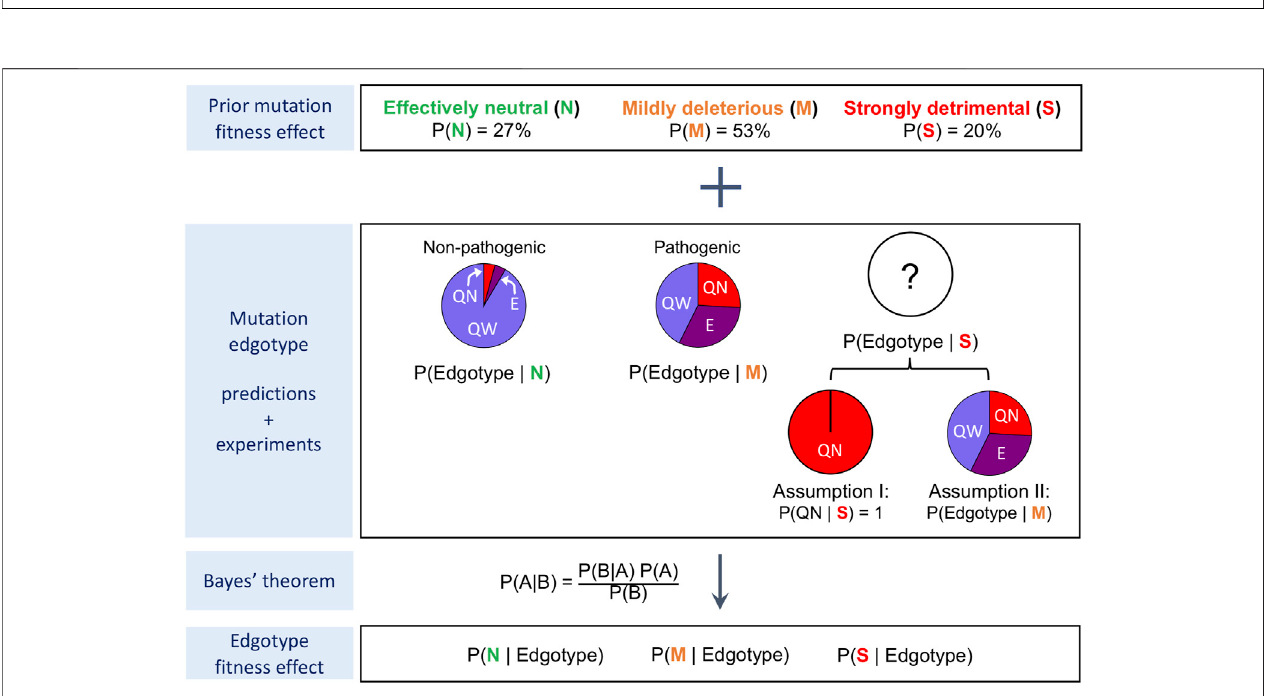
FIGURE 5 | Procedure for the calculation of edgotype fi tness effect. Bayesian framework used for the calculation of fi tness effects for quasi-wild-type mutations, edgetic mutations and quasi-null mutations. Under Assumption I, strongly detrimental mutations are all quasi-null. Under Assumption II, strongly detrimental mutations are as likely as mildly deleterious mutations to be quasi-wild-type, edgetic or quasi-null.